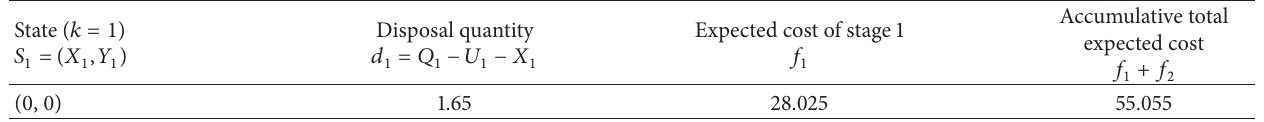
Table 6: The probable state and its expected cost of stage